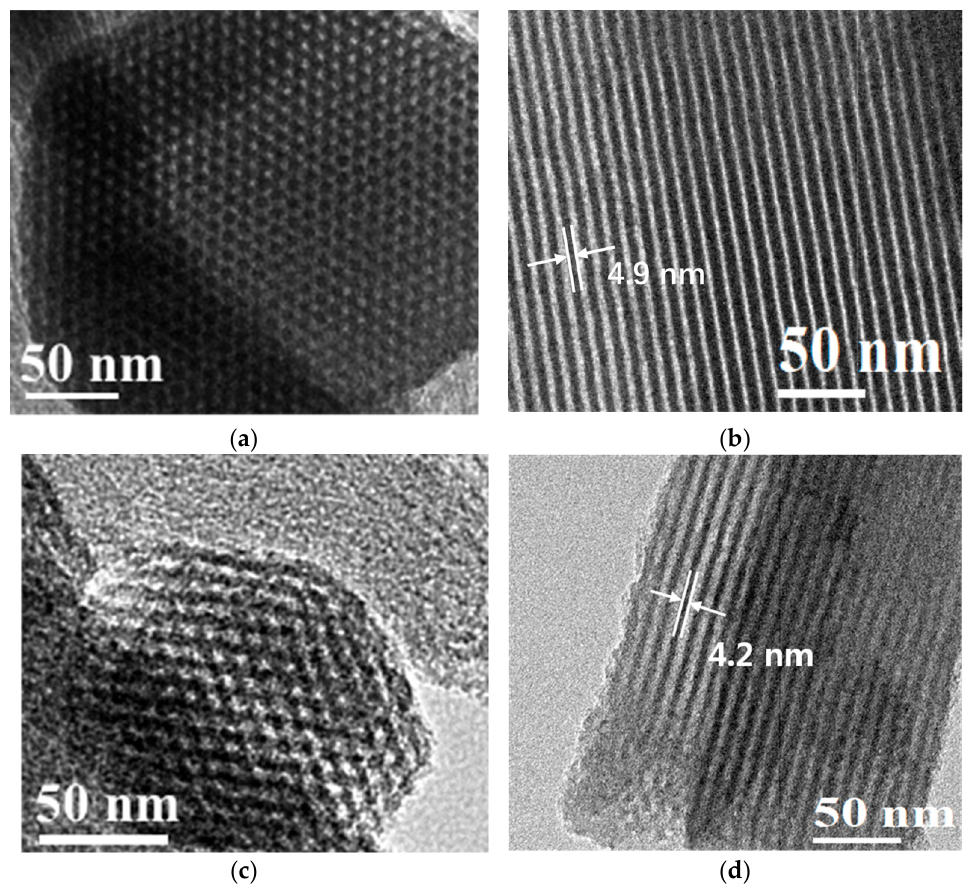
Figure 1. HR-TEM images of the SBA-15 and the 20%-TiO 2 -SBA-15 samples: ( a , b ) SBA-15 along with (100) and (001) directions, respectively; ( c , d ) 20%-TiO 2 -SBA-15 along with (100) and (001) directions, respectively.